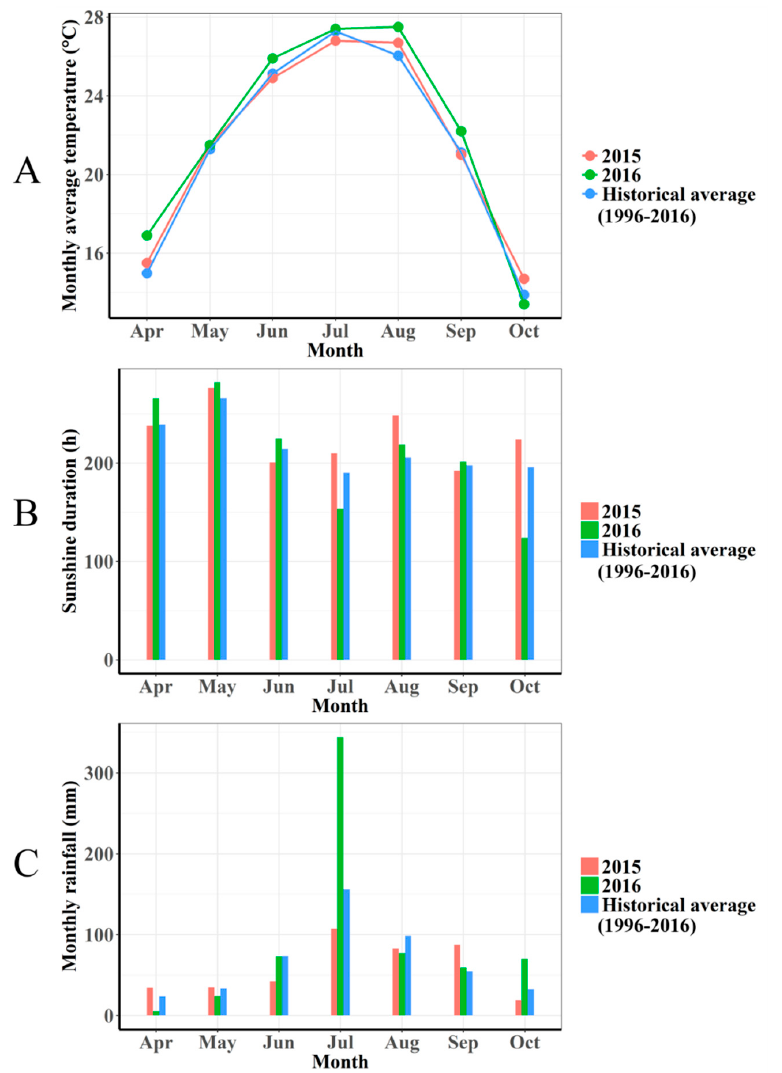
Figure 1. Meteorological data (monthly average temperature ( A ), sunshine duration ( B ), and rainfall ( C )) of the experimental field from April to October in 2015–2016. ( C )) of the experimental field from April to October in